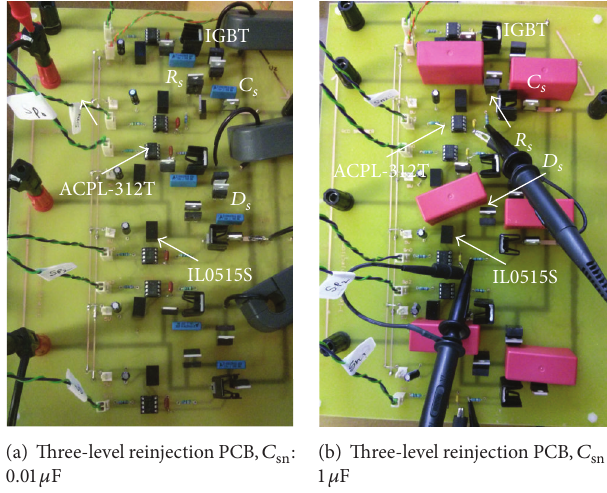
Figure 23: Two reinjection PCBs used in the prototype.